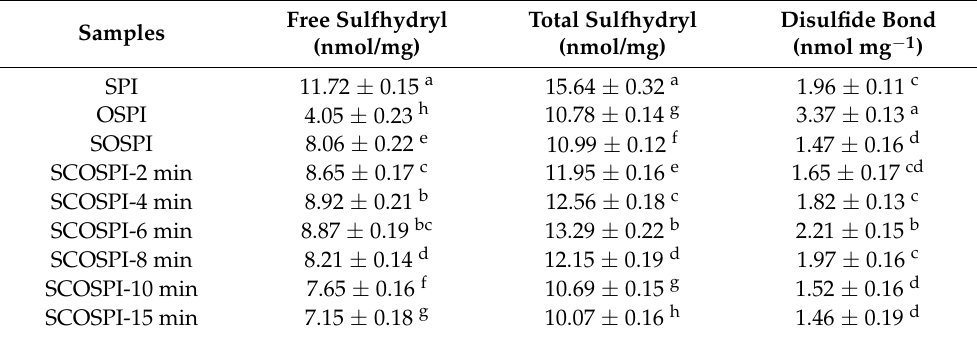
Note: Comparisons were carried out between values of the same column; values with a different letter(s) indicate a significant difference at p ≤